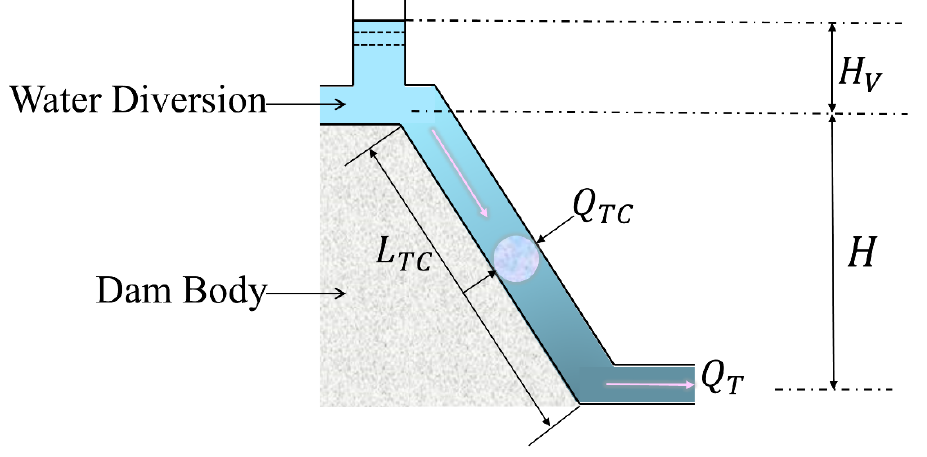
Figure 3. Schematic diagram of dam power generation.